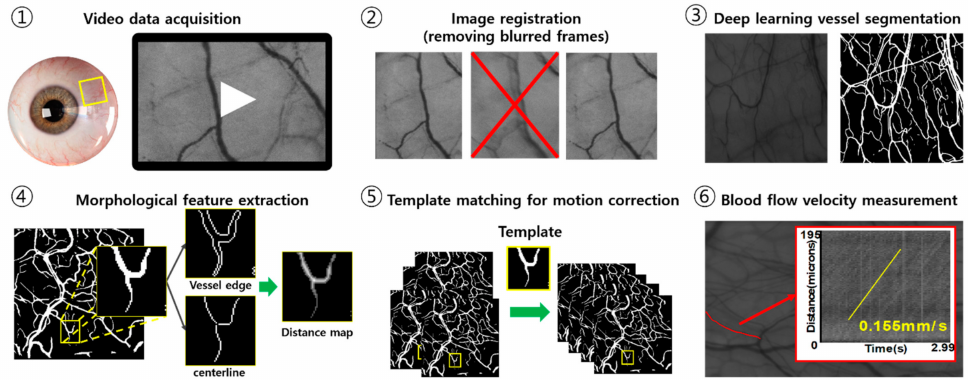
Figure 1. The summary of experimental phase in this